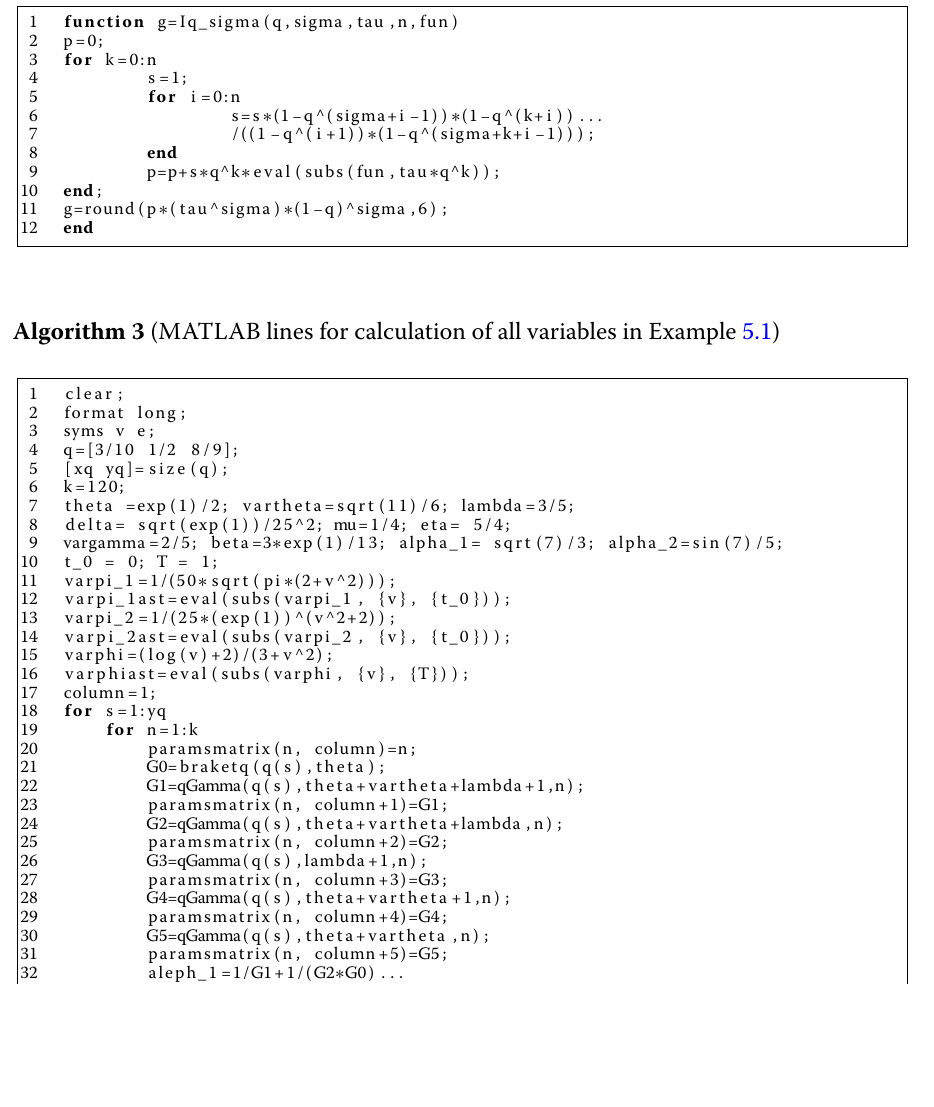
Algorithm 2 (MATLAB function for calculation the fractional q -integral of the Riemann– Liouville type)